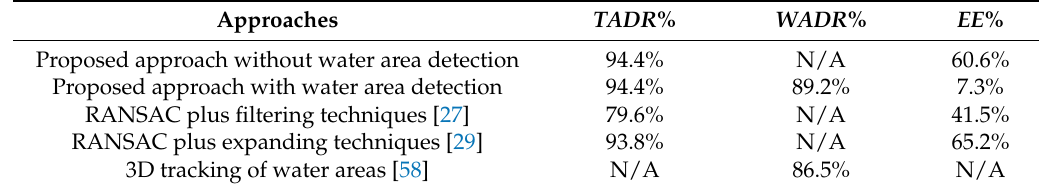
Table 1. Quantitative analysis.